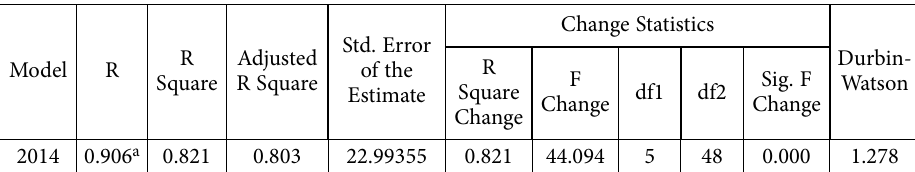
Table 1. Seasonal sustainability function for 2014